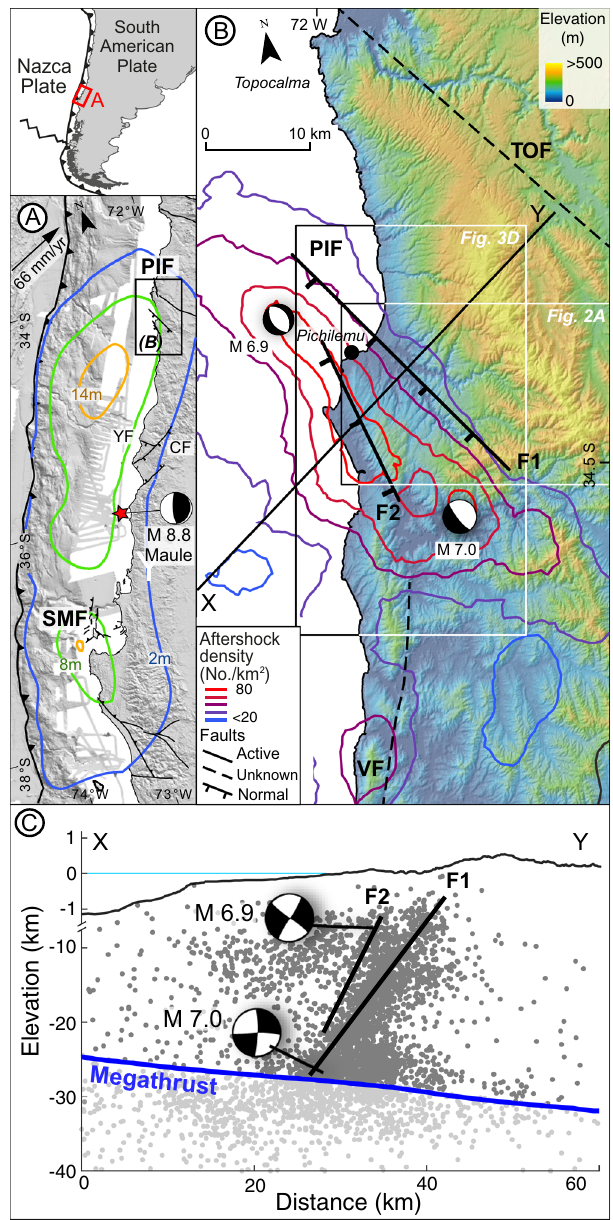
Fig. 1 Tectonic setting of the Pichilemu Fault. A Slip distribution for the 2010 Maule earthquake 31 and active faults from the Chilean Active Fault database 58 . The Santa María Fault (SMF) and Pichilemu Fault (PIF) were reactivated by the earthquake 4,19 . YF: El Yolki Fault; CF: Carranza Fault. B Topography (SRTM data from www2.jpl.nasa.gov), faults, and focal mechanisms of the PIF earthquakes 4 in the Pichilemu region. Contours show aftershock density after the Maule earthquake. Thick black lines denote the PIF branches (F1 and F2). Also shown are the Topocalma Fault (TOF), a Quaternary normal fault, and Vichuquén Fault (VF), an inferred fault affecting the crystalline basement 4 . C Crustal pro fi le showing aftershocks (Mw > 1) recorded between March 15 and September 30, 2010 33 , used to infer the subsurface geometry of the PIF. Megathrust from Slab 2.0 model 47